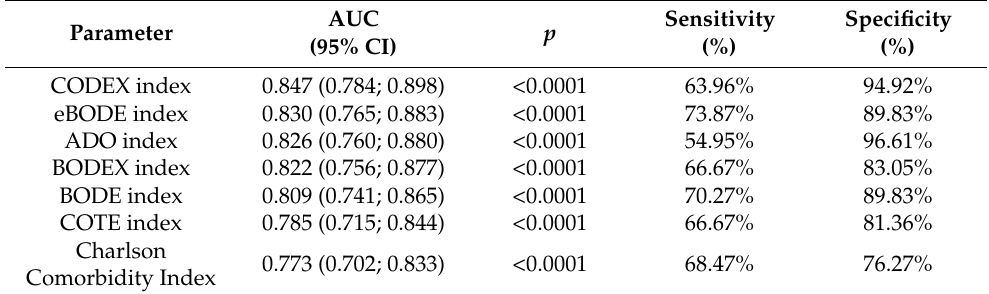
Table 4. Results of receiver operating characteristic (ROC) curve analysis for 10-year